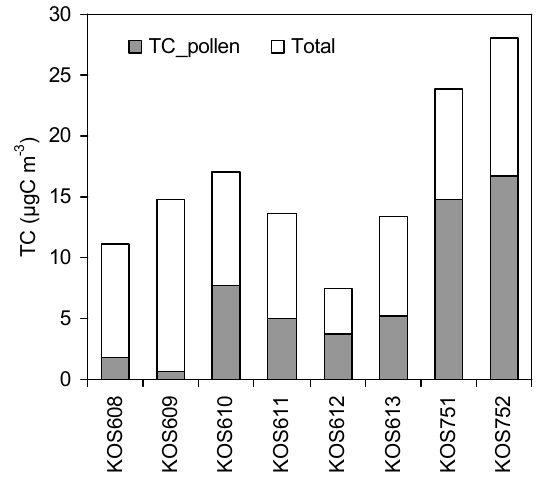
Fig. 9. Temporal variations of mass concentrations of TC and air- borne pollen carbon (TC pollen ) determined using the isotope mass balance